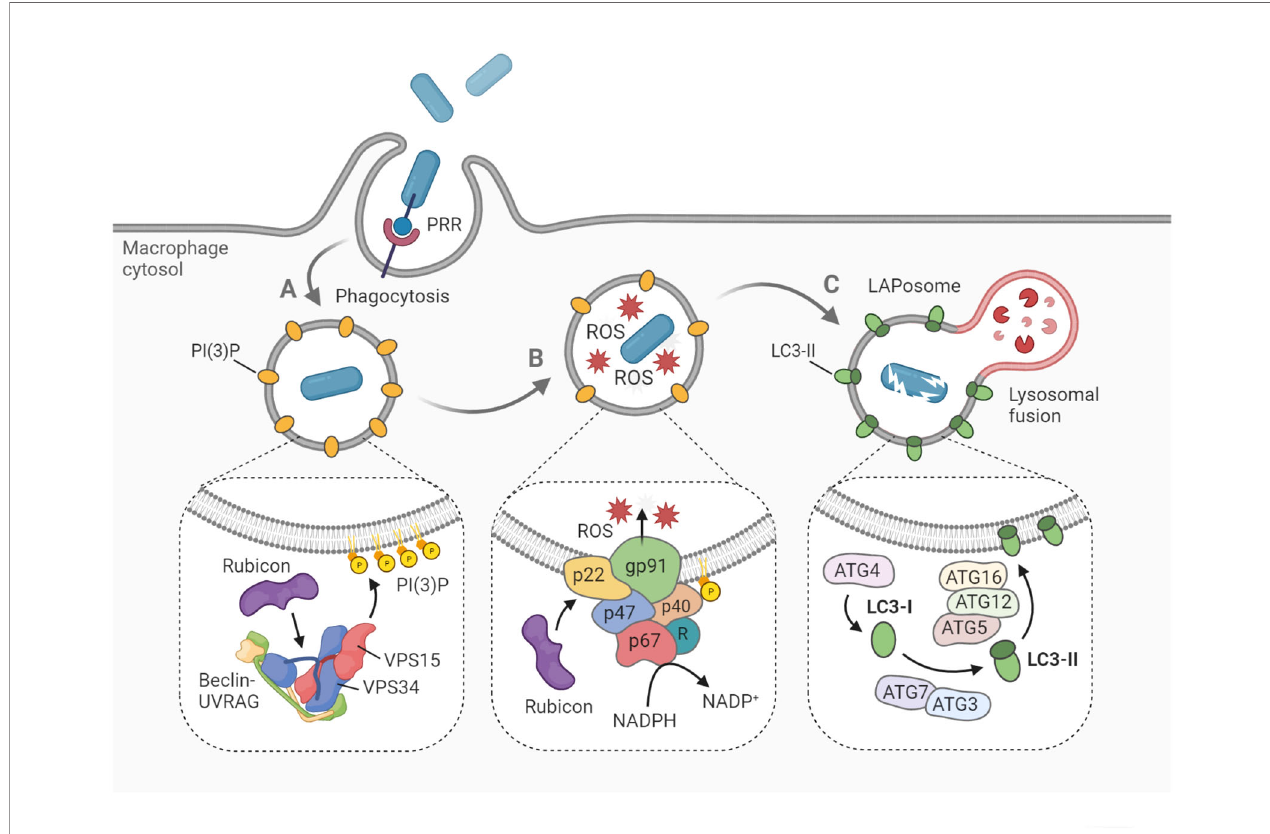
FIGURE 1 | Hallmarks of LAP on the molecular level. LAP begins with pattern recognition receptor (PRR)-mediated phagocytosis of pathogens, dying cells and other particles. (A) The phagosome is marked with PI(3)P, a signaling lipid which is generated by the PI3KC3 complex, consisting of Beclin-1, UVRAG, VPS15, VPS34 and Rubicon. (B) Within the phagosome, ROS are produced by the NADPH oxidase complex. Rubicon stabilizes the complex via interaction with p22 phox , while p40 phox interacts with PI(3)P to recruit the remaining components. (C) Cytosolic LC3 is lipidated by the conjugation machinery to form LC3-II on the phagosomal membrane. Soon after, the LAPosome fuses with an available lysosome resulting in rapid degradation of the engulfed cargo. Figure created with